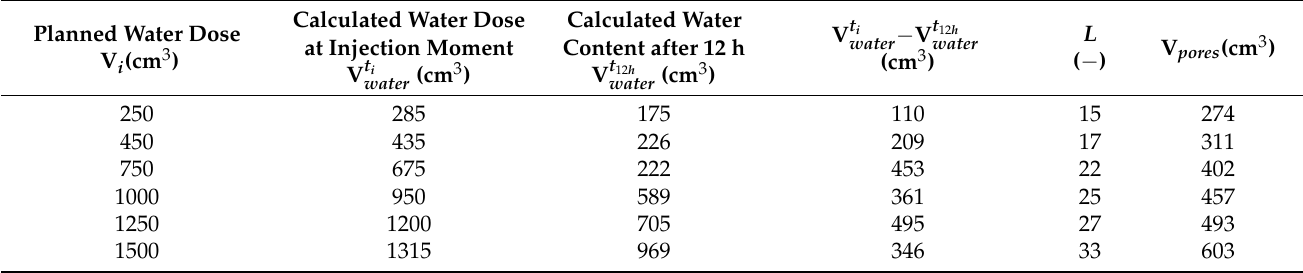
Table 2. Difference between the volume of pores available on the bottom of the sand monolith and the decrease of water content over time, for various water injection